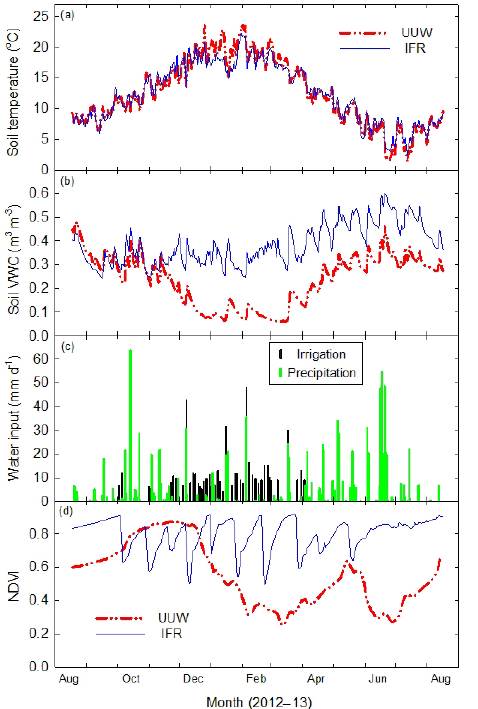
Figure 4. Time series at the UUW and IFR sites for daily means of (a) soil temperature and (b) soil moisture at 50mm depth; (c) daily sums of rainfall (both sites) and irrigation (IFR only); and (d) daily values of the Normalised Difference Vegetation Index (NDVI).